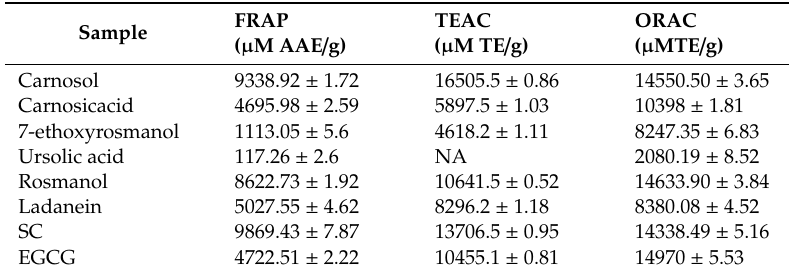
Table 2. Total antioxidant capacity of S. chamelaeagnea